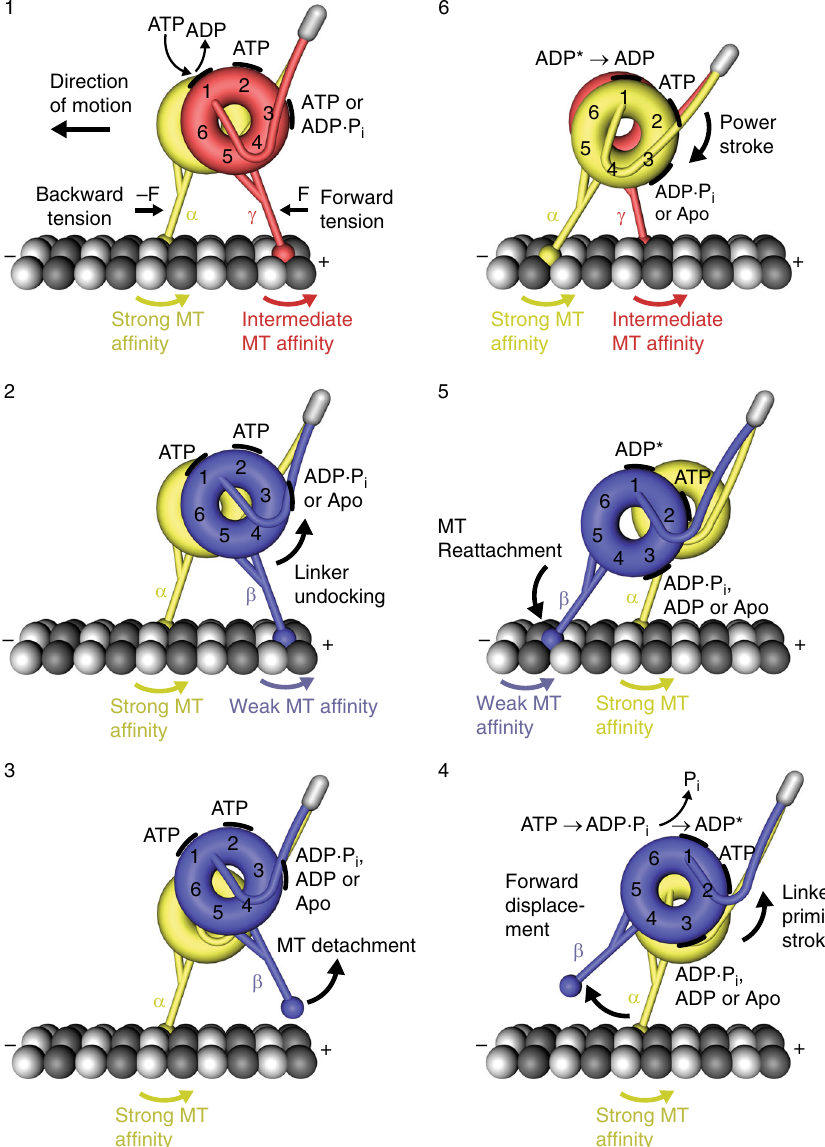
Fig. 8 Model for the mechanochemical cycle of dynein. Following ADP release from AAA1, ATP binding (step 1) causes the undocking of the linker from AAA5 and the subsequent transition from the γ -registry of the stalk helices with intermediate weak MT-af fi nity to the weakly MT-binding β -registry (step 2). After the detachment of the rear head (step 3), which occurs when AAA3 is in the ADP ∙ Pi transition state or bound to ADP, the ‘ recocking ’ of the linker (priming stroke) displaces the detached head forward to a new front MT-binding site while the MT-attached head bears the load (step 4). Following ATP hydrolysis and Pi release from AAA1 (step 4), rebinding to the MT in the weakly MT-binding β -registry (step 5) causes the transition from the ‘ high-energy ADP* state ’ to the ‘ low-energy ADP state ’ , which generates a linker swing (powerstroke), resulting in the docking of the linker to AAA5 and the transition into the strong MT-binding α -registry of the stalk helices (step 6). A prerequisite for the strong binding state is that AAA3 is not bound to ADP, suggesting that AAA3 is still in the ADP ∙ Pi state or nucleotide free. The MT minus-end-directed linker swing generates the forward movement of dynein ’ s center of mass and the attached terri fi c broth (TB) with 30 μ g/mL of kanamycin and grown overnight shaking at 37°C. Plasmids (listed in Supplementary Table 1) were puri fi ed using the Pure- Yield plasmid miniprep kit from Promega and veri fi ed by standard sequencing. Yeast growth and yeast dynein expression . Single-headed dynein constructs (based on tail-truncated dynein, Dyn1 331kDa ) were expressed behind the inducible galactose promoter (GAL1-GAL10), while two-headed full-length dynein con- structs (based on Dyn1 471kDa ) were expressed behind the native promoter 61 . Yeast growth was done at 30 °C with shaking. For single-headed dynein, a single yeast colony was inoculated in 5mL of 2× YPD (20 g/L yeast extract, 40g/L peptone, 4% (w/v) dextrose) overnight. Pre-cultures were then inoculated in 50mL of YPR (2% (w/v) raf fi nose) for 8 h. Expression of dynein was induced by transferring the YPR